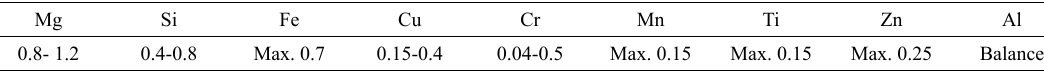
Table 2. Mechanical properties